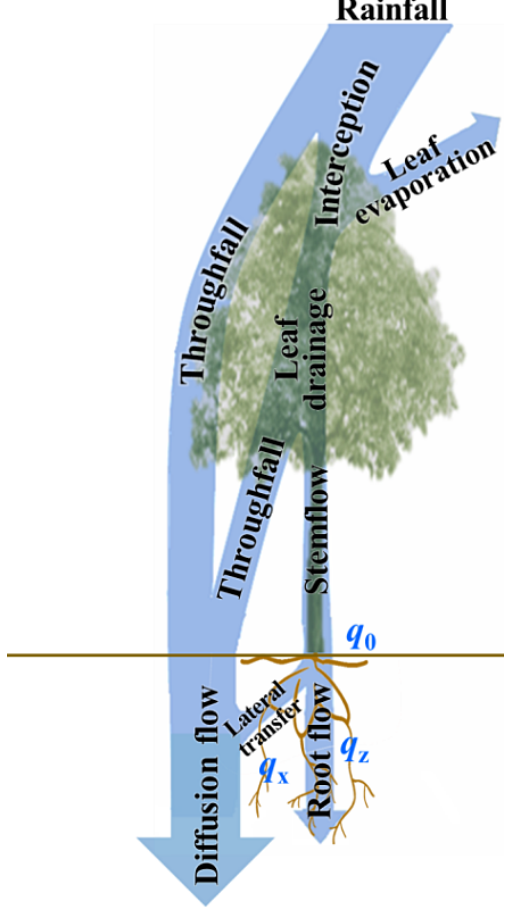
Figure 1. Stem–root flow conceptual diagram. Leaf drainage in the model can be separated into throughfall and stemflow. Following the stemflow path, rainwater can continue via the root system to reach deep soil layers and the water table. The stemflow that reaches the top soil layer, q 0 , is divided into a downward transfer flux (i.e., the root flow) q z and a lateral transfer flux q x (from the root sur- face to the soil), and the two transfer fluxes regulate the root-flow